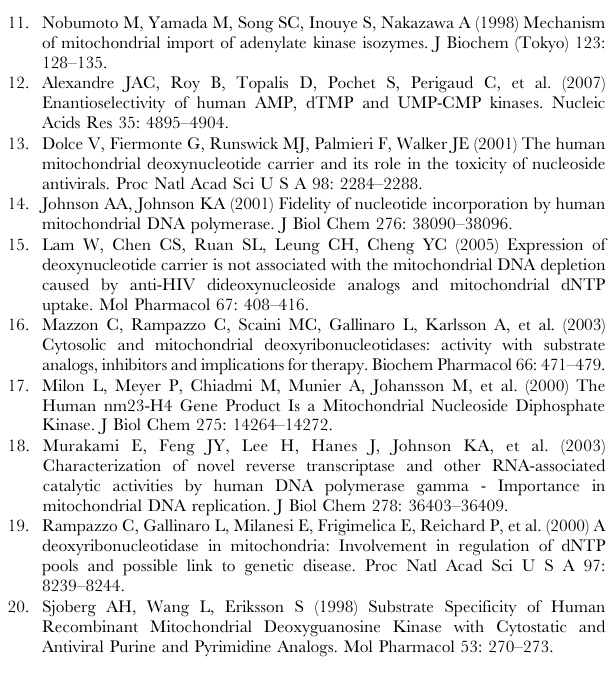
Table S1 k cat /K m , Concentration/K m , and inhibition data for the enzymes.